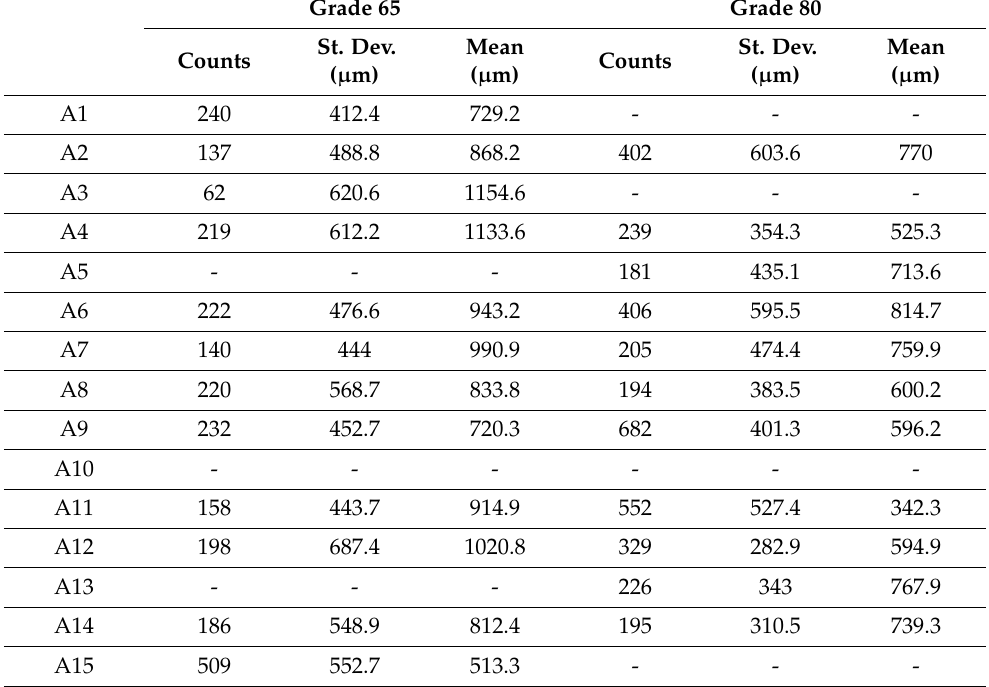
Table A10. Mean Cell’s Feret diameter ( d C ) of CFF samples of Grade 65 and Grade 80 from supplier A.